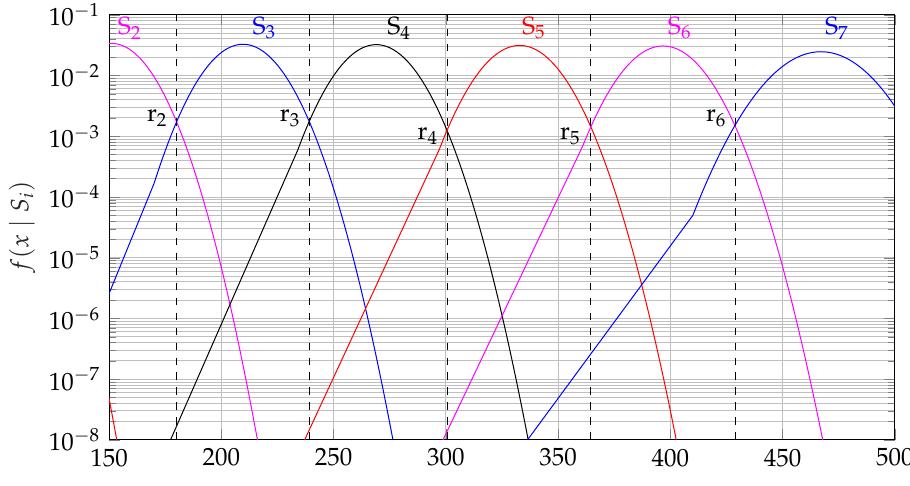
Figure 4. Fitted voltage distributions for a TLC flash at